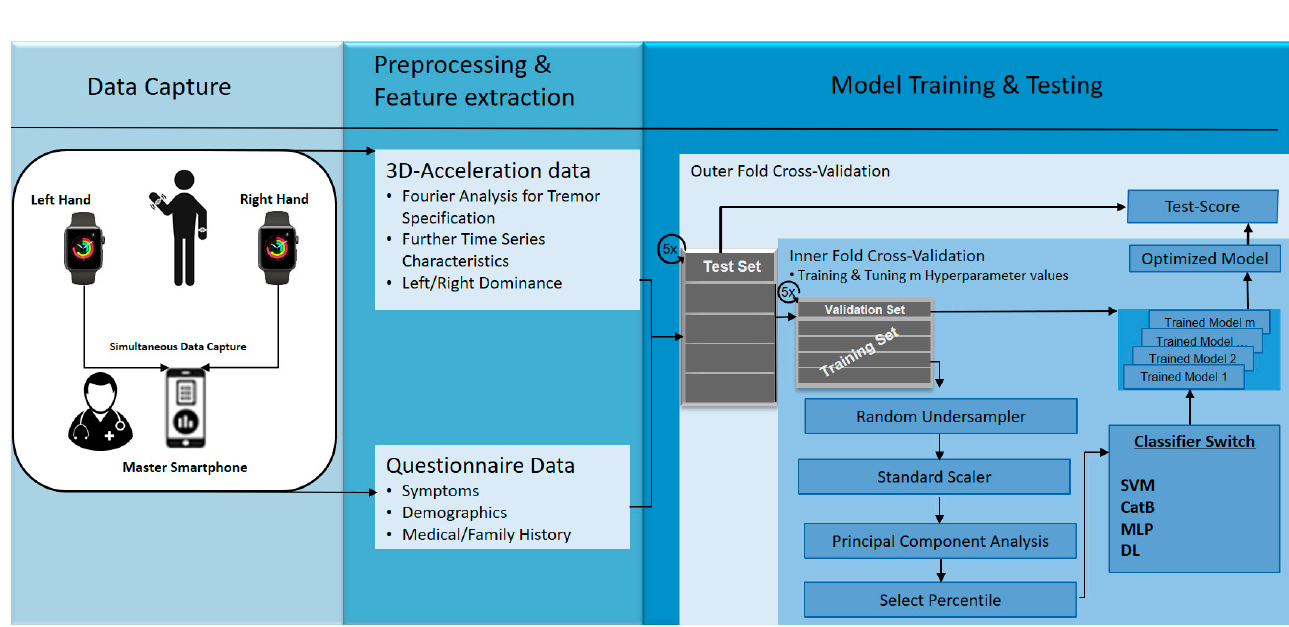
Figure 3. Overview of data analytics pipeline. SVM = support vector machine with radial basis function. CatB = CatBoost, MLP = multi-layer perceptron with two hidden layers, DL = deep-learning architecture. Table 3. Machine Learning Features.